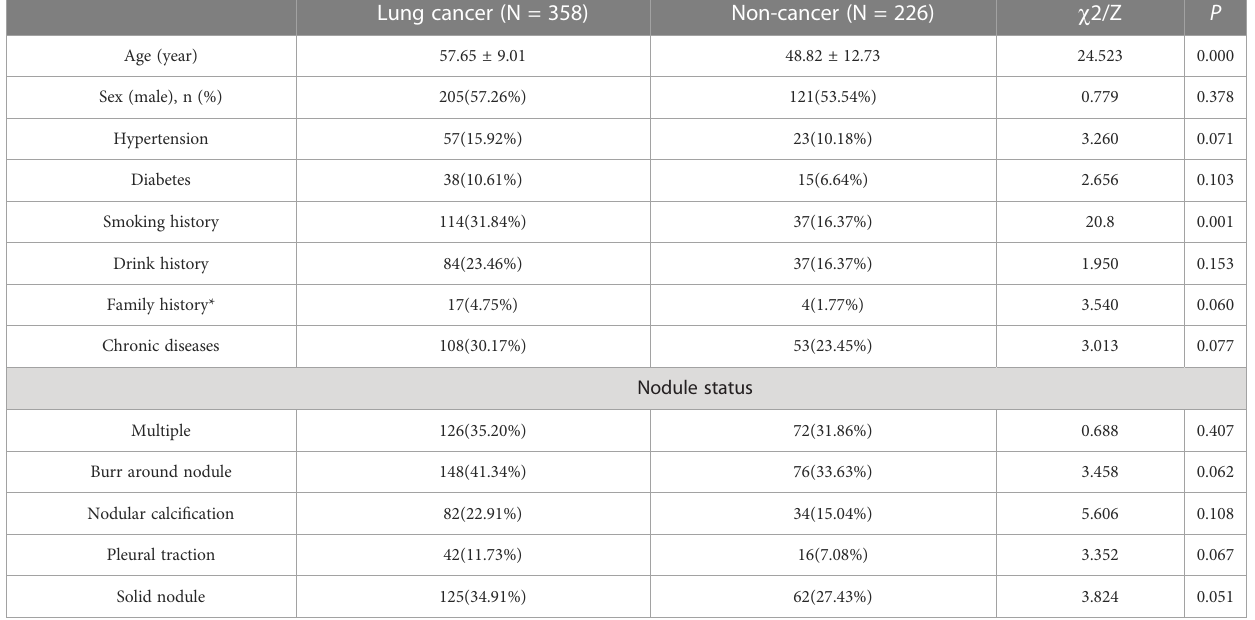
TABLE 1 All patients ’ baseline clinical features